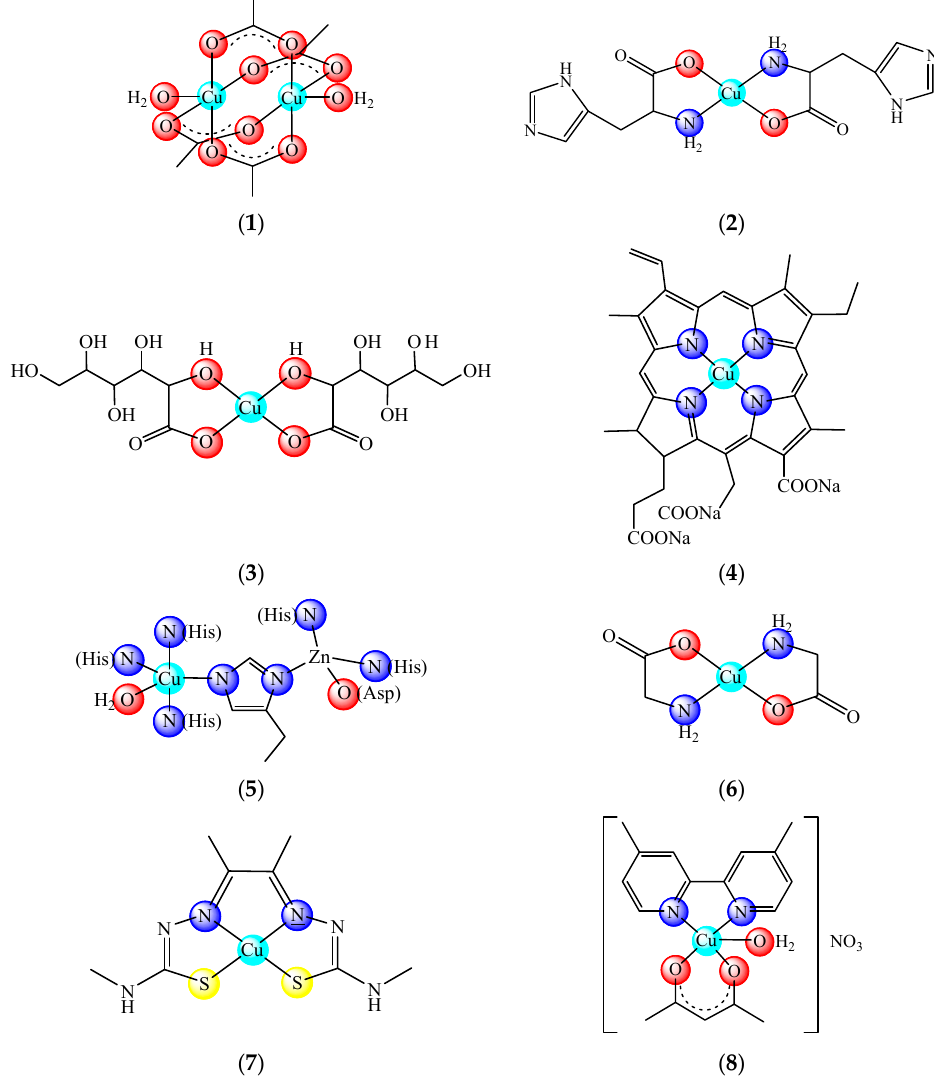
Figure 1. Copper-based drugs: [Cu 2 (CH 3 COO) 4 (OH 2 ) 2 ] ( 1 ) and [Cu(His) 2 ] ( 2 ) for relieving symptoms Figure1. Copper-baseddrugs: [Cu 2 (CH 3 COO) 4 (OH 2 ) 2 ]( 1 )and[Cu(His) 2 ]( 2